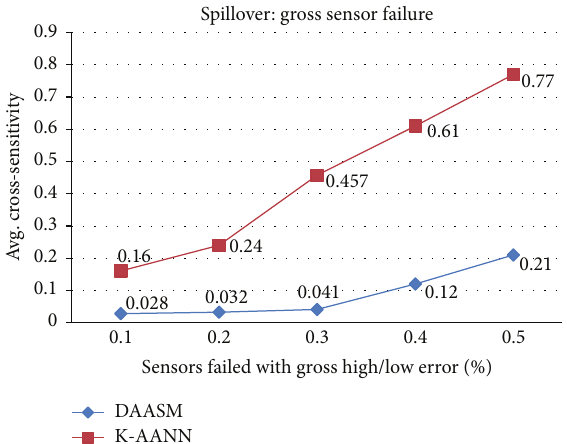
Figure14:Comparisonofspillovereffectagainstsimultaneousgross high/low failure in multiple sensors.